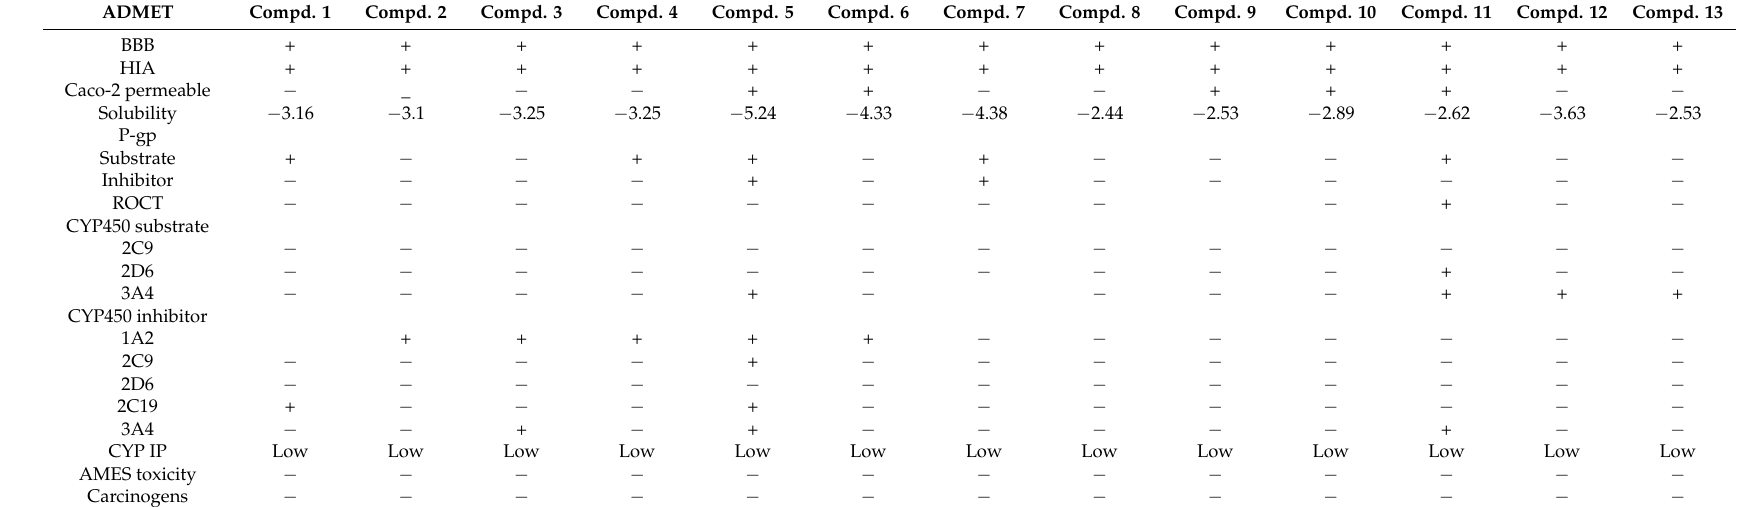
Table 1. Predicted ADMET assessment of 13 virtual